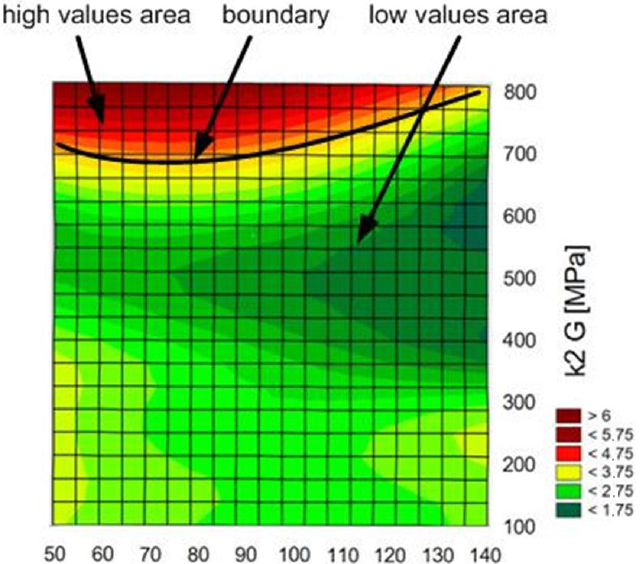
Figure 17. Diagram of fracture energy [J] in function of rigidity modulus of both adhesives.